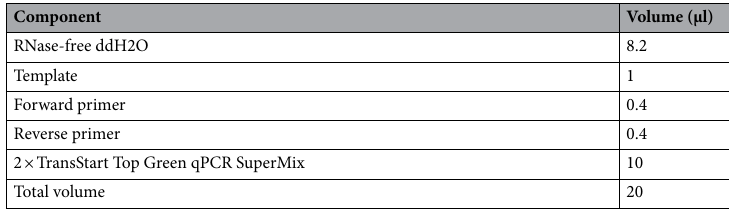
Table 2. Real-time fluorescence quantitative PCR reaction system. (1) Predenaturation at 94 °C for 30 s; (2) Denaturation at 94 °C for 5 s, annealing at 60 °C for 15 s, extension at 72 °C for 10 s, circulating 40